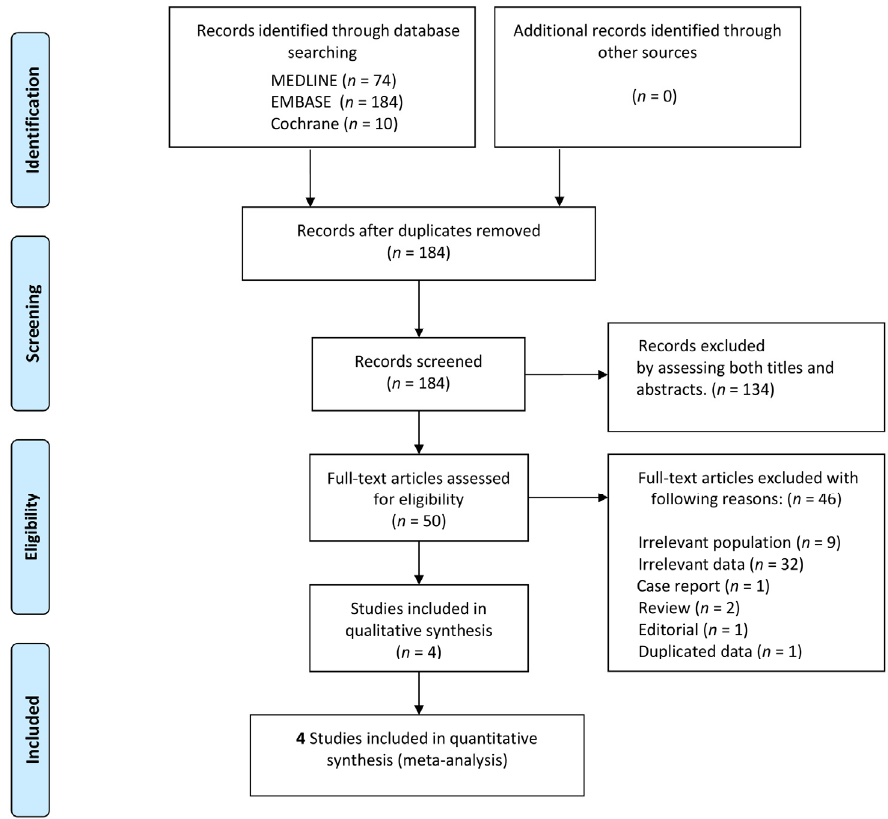
Figure 1. The flow diagram depicts the studies that were included in the meta-analysis.